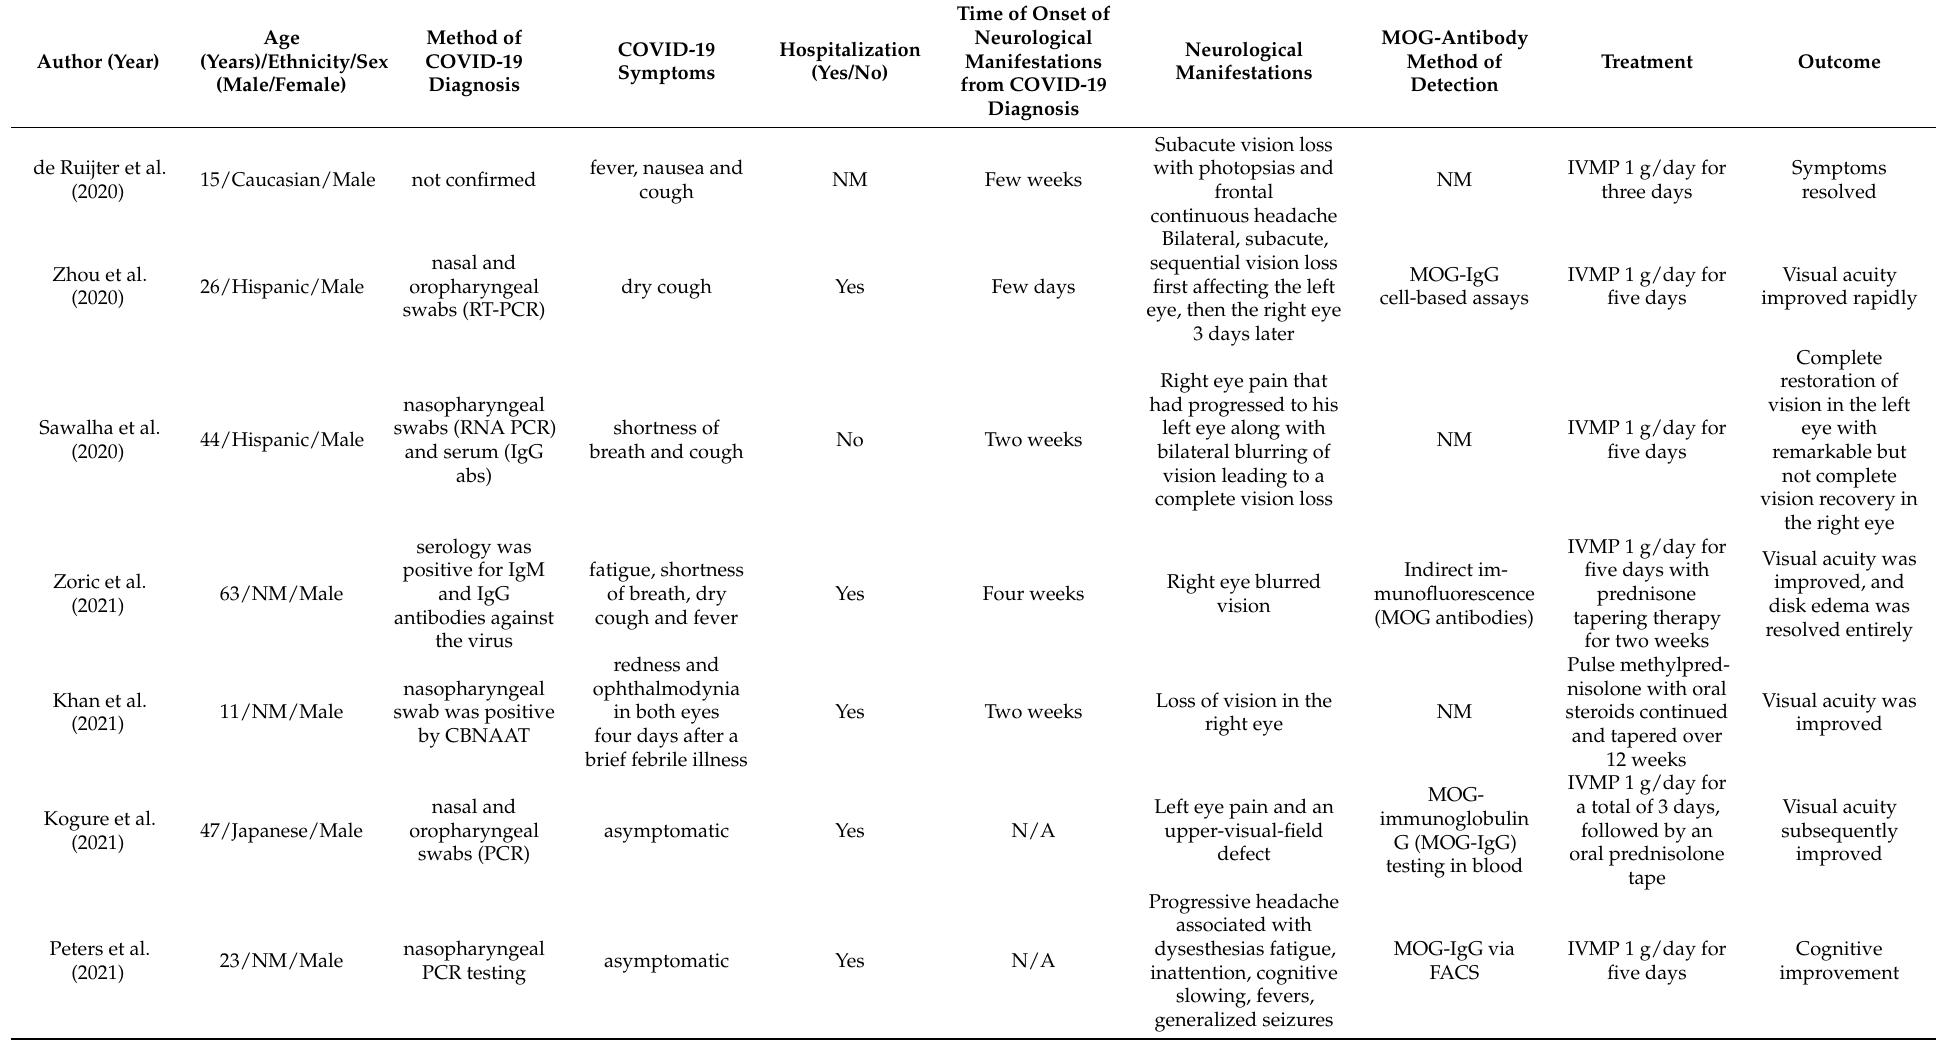
Table 1. Characteristics of patients with anti-MOG positive optic neuritis and anti-MOG encephalitis secondary to COVID-19